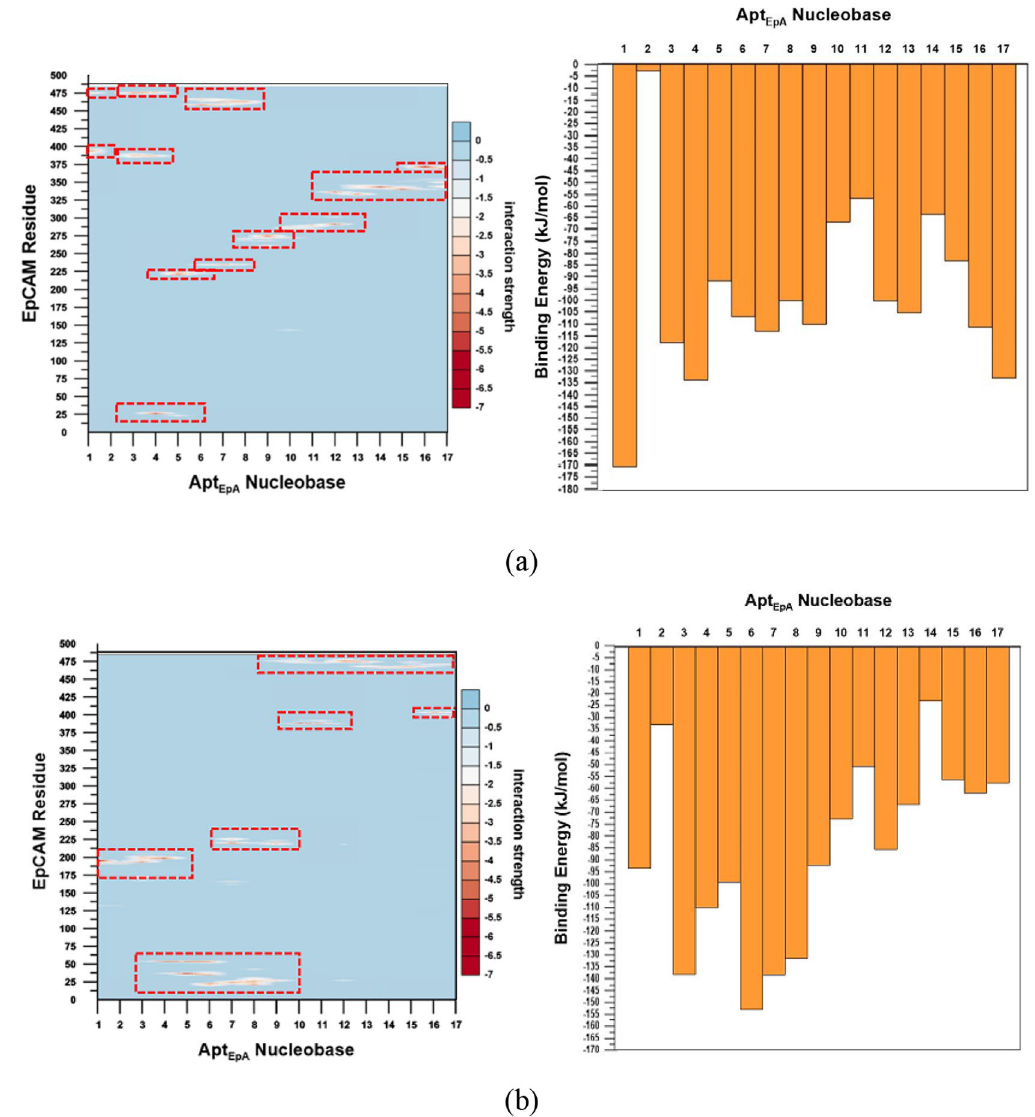
Figure 11. The interaction details between Apt EpA nucleobases and EpCAM for ( a ) CG_Case1 and ( b ) CG_ Case2. Left panel: contour map showing the interaction energy distribution of each Apt EpA nucleobase with each EpCAM residue. Right panel: histogram plot showing the interaction energy between EpCAM and an Apt EpA nucleobase in the water environment. The dashed rectangles in the contour maps indicate Apt EpA nucleobases with relatively stronger interaction energies with EpCAM